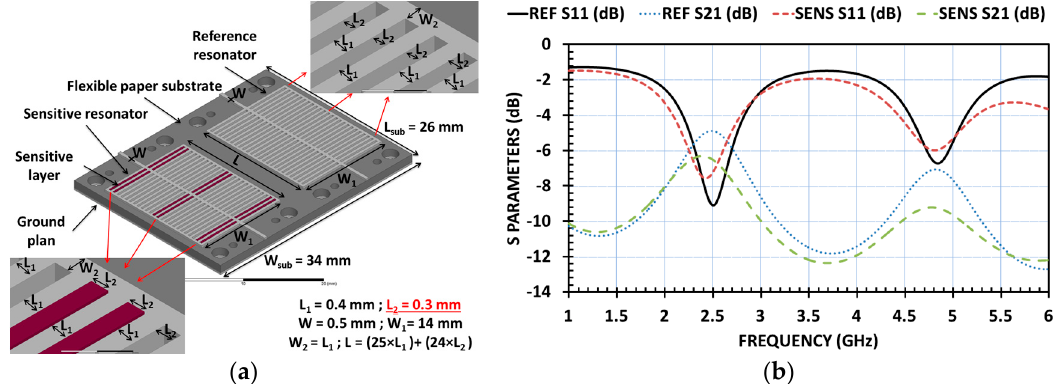
Figure 1. ( a ) Overview of the device geometry and ( b ) Simulated S parameters.